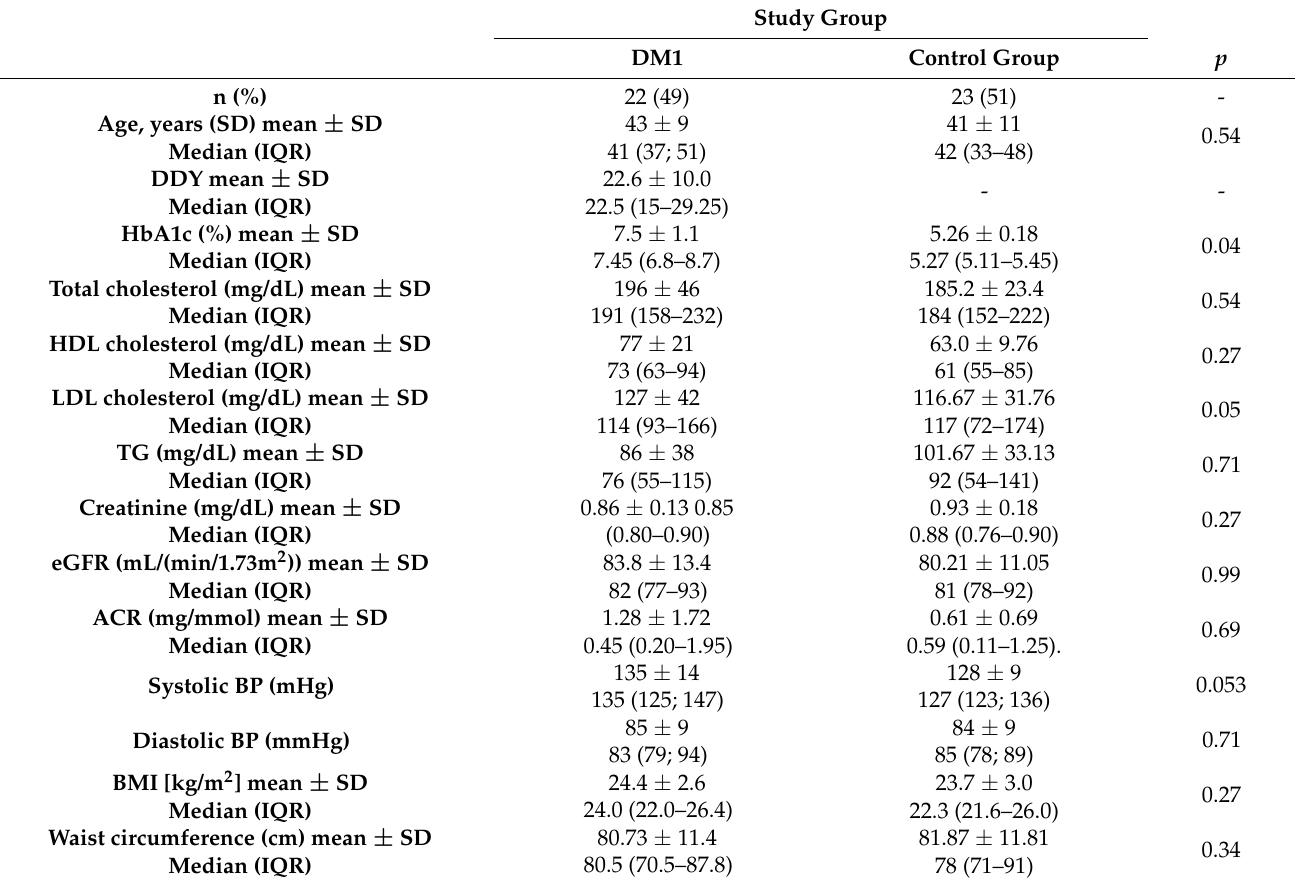
Table 2. Characteristics of the study group with metabolic control markers. DDY—diabetes duration years; TG—triglycerides; ACR—albumin to creatinine ratio; BP—blood pressure; BMI—body mass index; IQR—interquartile range (25 percentile; 75 percentile). Study